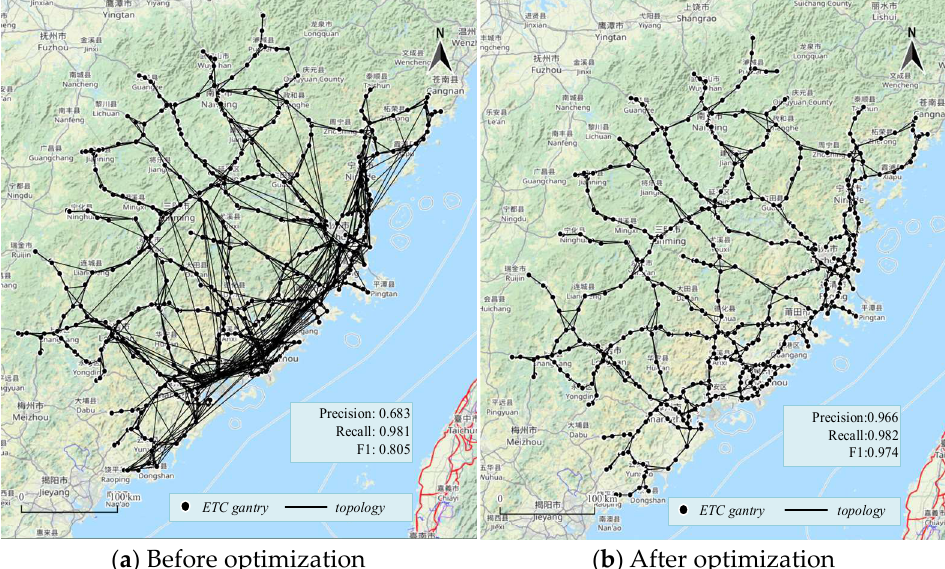
Figure 7. Visualization of road network topology.